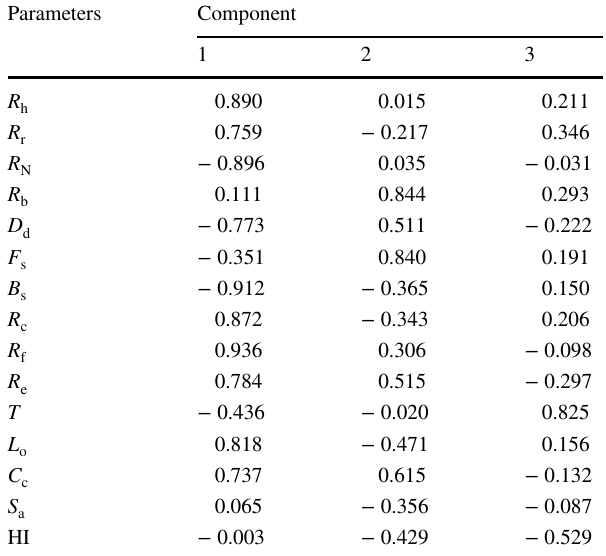
Table 10 Rotated matrix